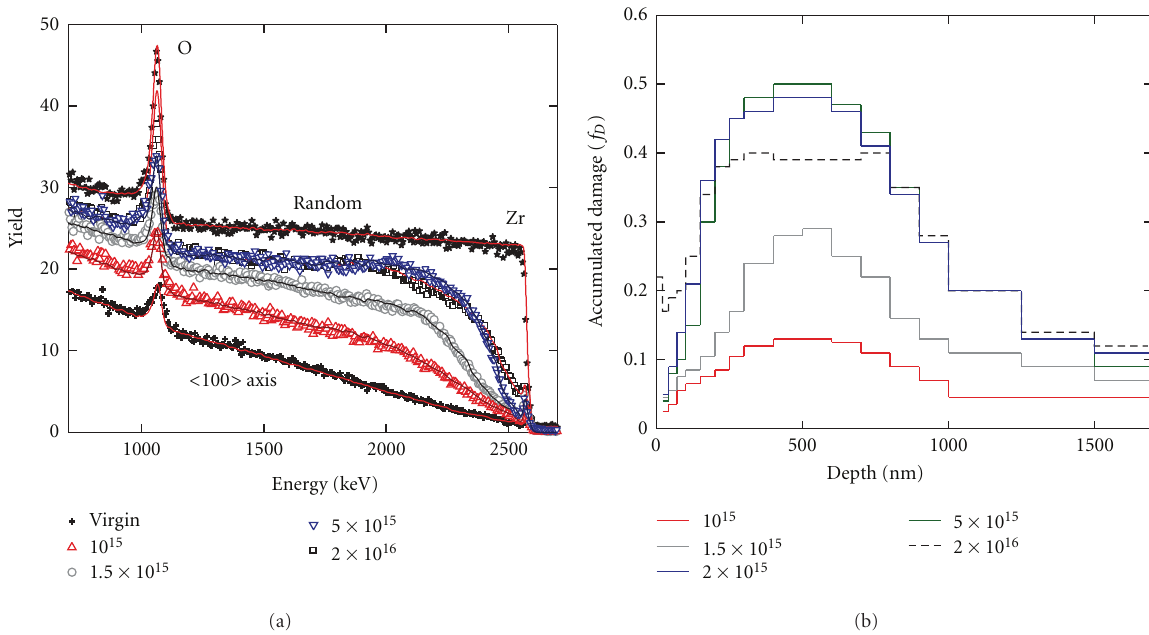
Figure 2: (a) RBS spectra recorded on cubic zirconia crystals irradiated at RT with 4-MeV Au ions in random (stars) and (cid:4) 100 (cid:5) -aligned (other symbols) directions (ion fluences are given in cm − 2 ). Energy of analyzing He beam: 3.07 MeV. Solid lines are fits to experimental data with the McChasy code [21, 22]. (b) Accumulated damage ( f D ) as a function of depth extracted from the fits to experimental RBS data for cubic zirconia crystals irradiated with 4-MeV Au ions at the indicated fluences.